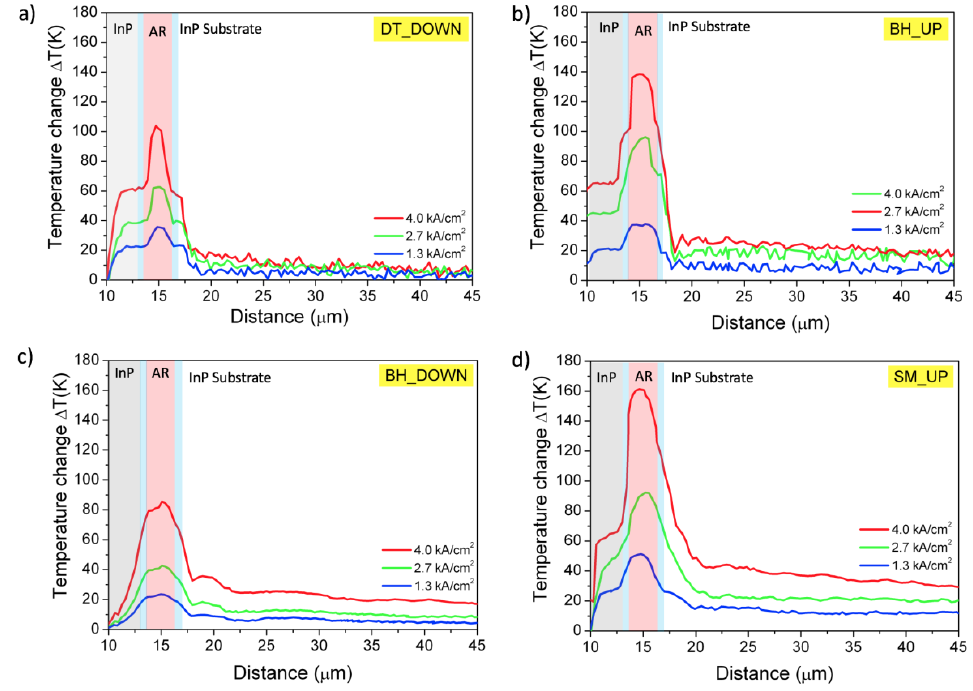
Figure 6. Temperature distribution line scans across the laser facet, taken at the center of the active area perpendicular to the epitaxial layers for different values of driving current: ( a ) DT epi-layer down mounted, ( b ) BH epi-layer up mounted, ( c ) BH epi-layer down mounted, and ( d ) SM epi-layer up mounted.